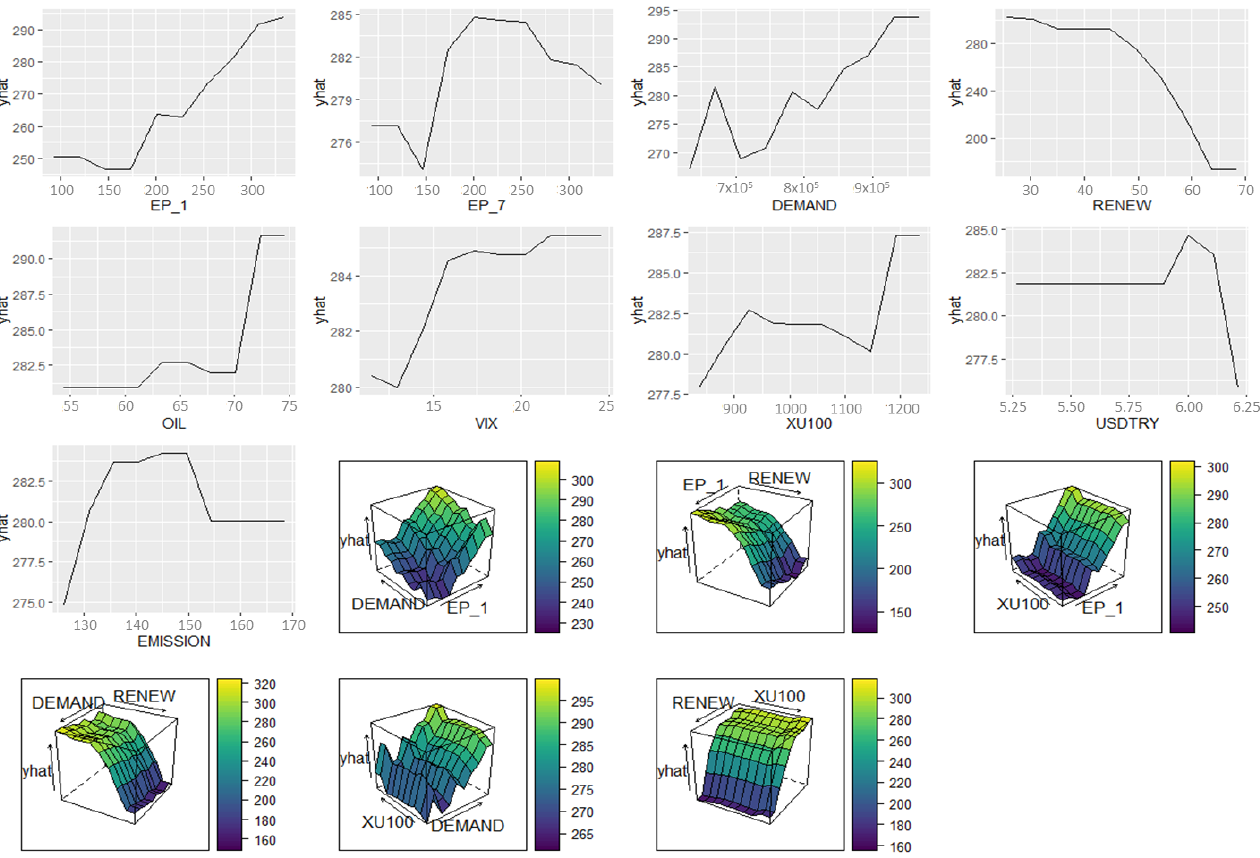
Figure 5. Single and interaction effects of independent v ariables in the pre-pandemic period.